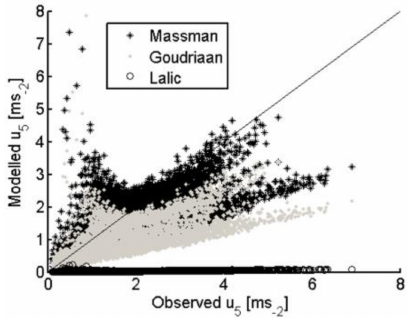
Figure 6. Wind-speed estimated and measured at 5 m over Las